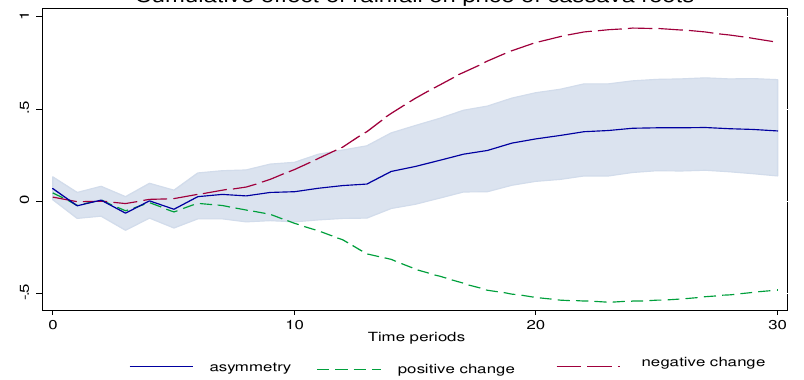
Fig. 3. Dynamic multipliers. Effect of rainfall on cassava root prices